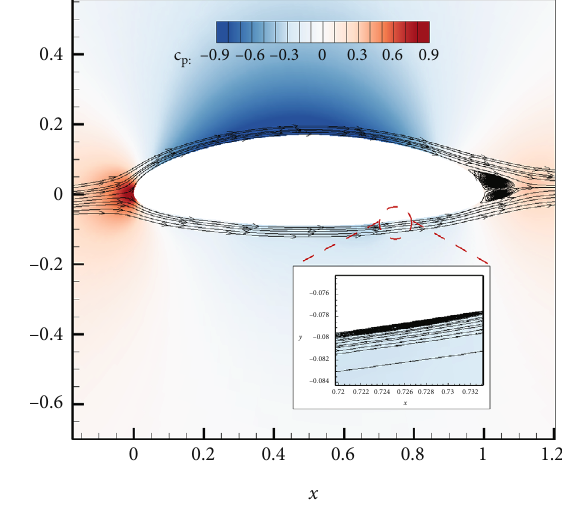
Figure 8: Pressure contour and streamlines ( Re = 1 : 4 E 6 , α = 2 °